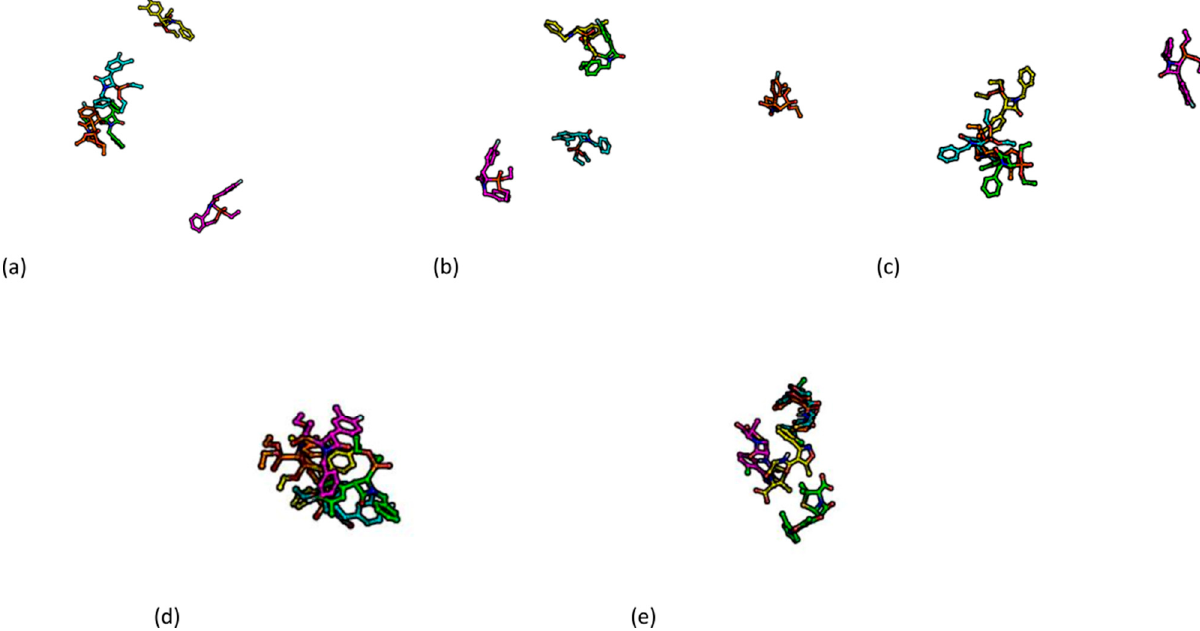
Figure 7. Selected frames from MD simulations for ( a ) (3 R ,4 R )- 11f , ( b ) (3 S ,4 S )- 11f , ( c ) (3 S ,4 R )- 11f , ( d ) (3 R ,4 S )- 11f , ( e ) oxacillin with β -lactamase; frame 1–green, 250–yellow, 500–magenta, 750–cyan, 1000–orange.